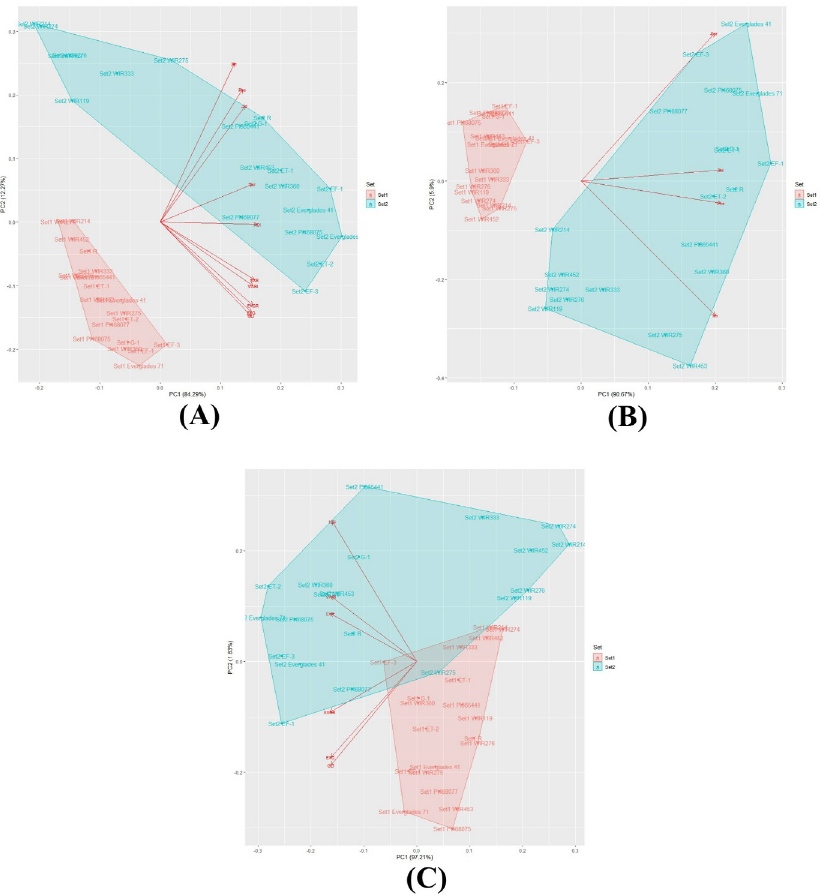
Fig 7. PCA analysis of 20 kenaf entries at two different growth stages. (A) PCA analysis by surface of individual plant, expected plant height, stem diameter, number of nodes, EXG, EXGR, EXR, GLI, NDI, and VARI; (B) PCA analysis by surface of individual plant, expected plant height, stem diameter, and number of nodes; (C) PCA analysis by EXG, EXGR, EXR, GLI, NDI, and VARI. Set 1, and set 2 measured June 22, and August 31.